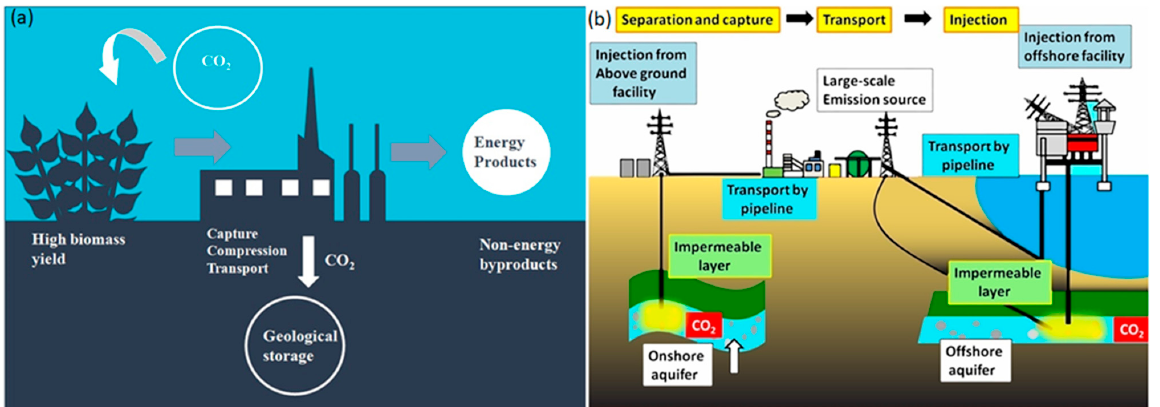
Figure 1. ( a ) The figure depicts the cycle of carbon capture, transportation and further storage. ( b ) The figure shows the cycle of the carbon that it follows after sequestration involving human-made transport lines and the natural flow of carbon.